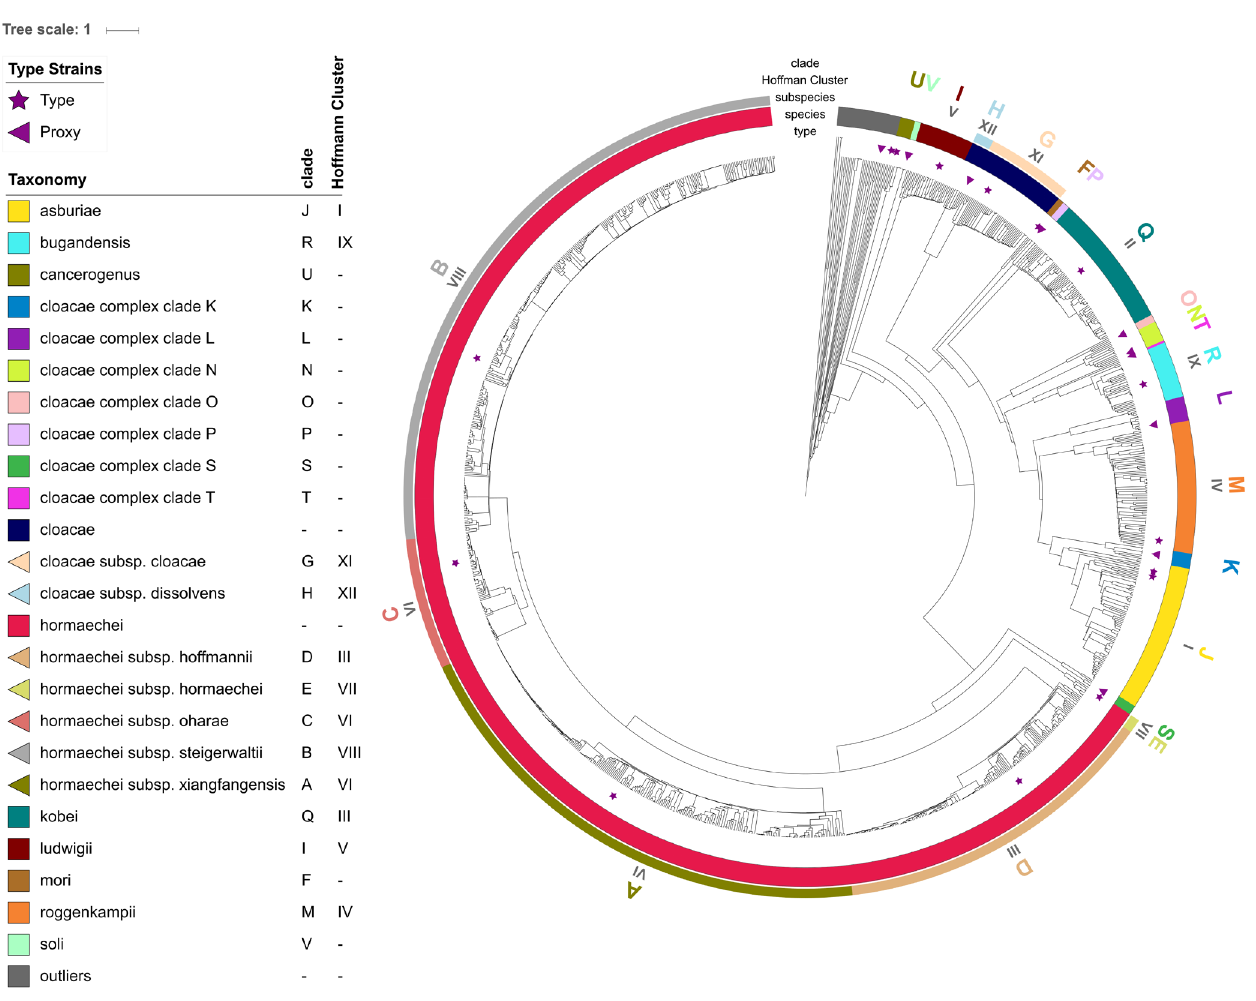
Figure 1. Average nucleotide identity (ANI) based tree for 1,249 NCBI RefSeq Enterobacter labelled genomes.